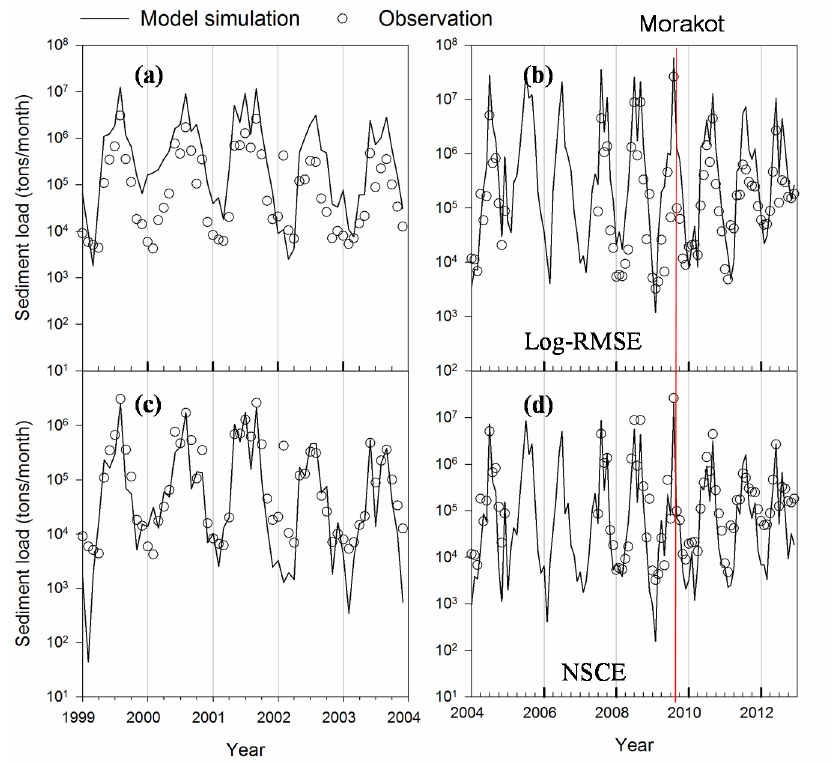
Figure 11. Comparisons between the simulated and observed monthly suspended sediment load in the calibration (left) and validation (right) periods. Sub-figures ( a , b ) are the simulated results from the log-RMSE calibrated parameters; sub-figures ( c , d ) are the simulated results from the NSCE calibrated